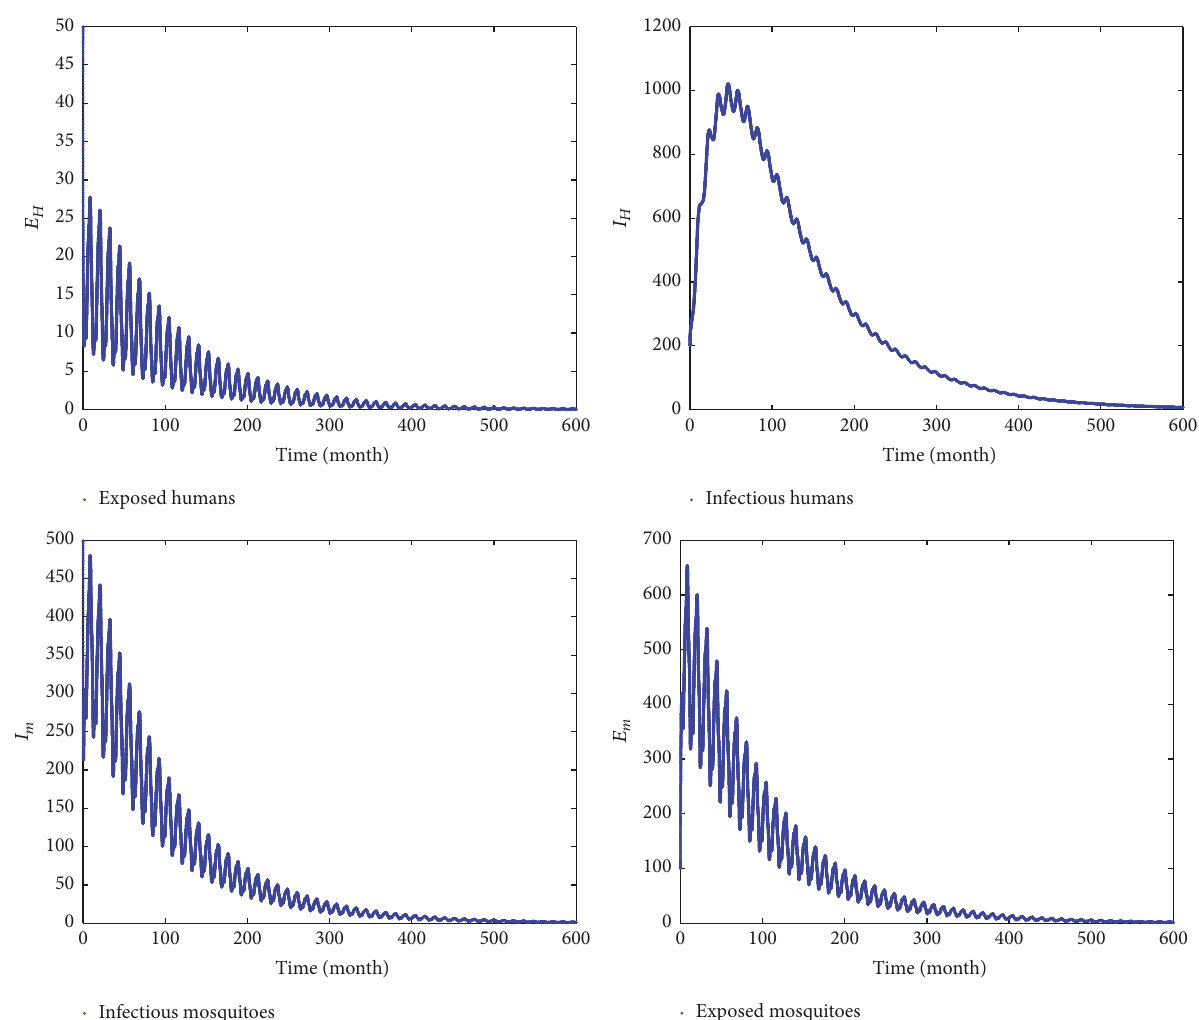
Figure 8: Distribution of infected humans and mosquitoes for 𝑏 = 180 , 𝑠 = 15 , 𝑑 = 6 , 𝑠 𝐿 = 15 , and 𝑑 𝐿 = 7.5